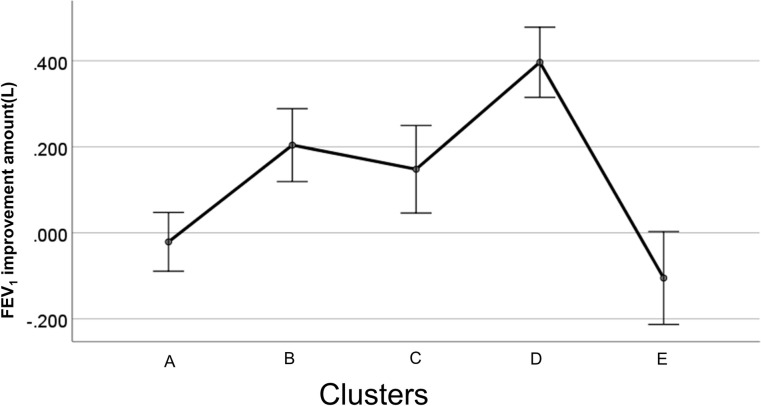
Early responsiveness to benralizumab in FEV1 by cluster.The observed absolute changes from baseline FEV1 (L) in response to benralizumab over 4 months. The error bar represents standard error.